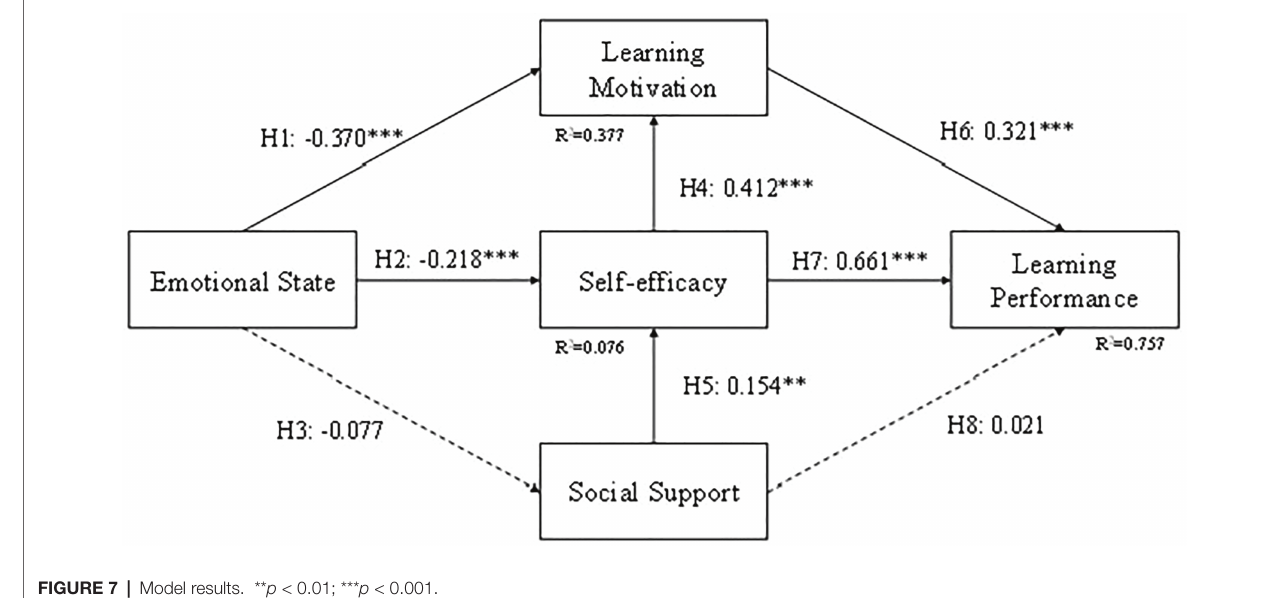
FIGURE 7 | Model results. ** p < 0.01; *** p < 0.001.